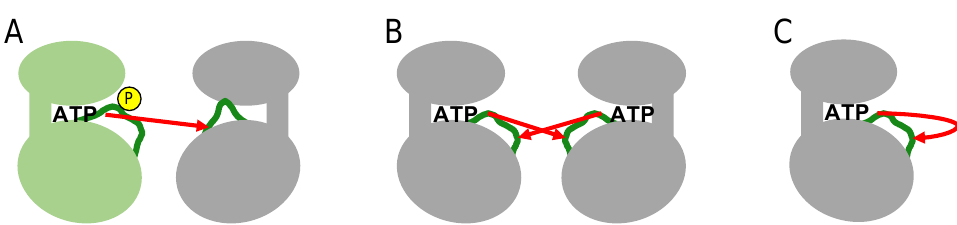
Figure 4. Graphical representation of activation loop phosphorylation. The green loops are the activation loops. The red arrows indicate the transfer of the phosphate group from ATP. ( A ) An active kinase with a phosphorylated (yellow) activation loop phosphorylates the activation loop of an inactive kinase. ( B ) Intermolecular autophosphorylation of activation loops of proximal kinases. ( C ) Intramolecular autophosphorylation of the activation loop of an inactive kinase.